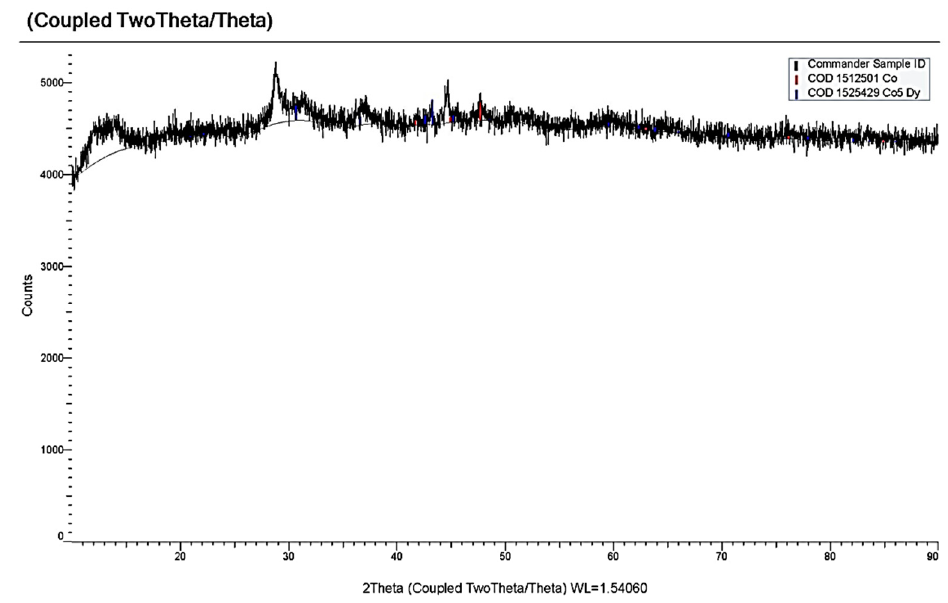
Figure 10. X-ray pattern of the cathode deposit obtained by electrolysis of the KCl-NaCl-DyCl 3 - CoCl 2 melt at 973 K for 1 h and the voltage of 3.4 V. Concentration of DyCl 3 is 3.0 × 10 − 4 mol/cm 3 . Concentration of CoCl 2 is 0.5 × 10 − 4 mol/cm 3